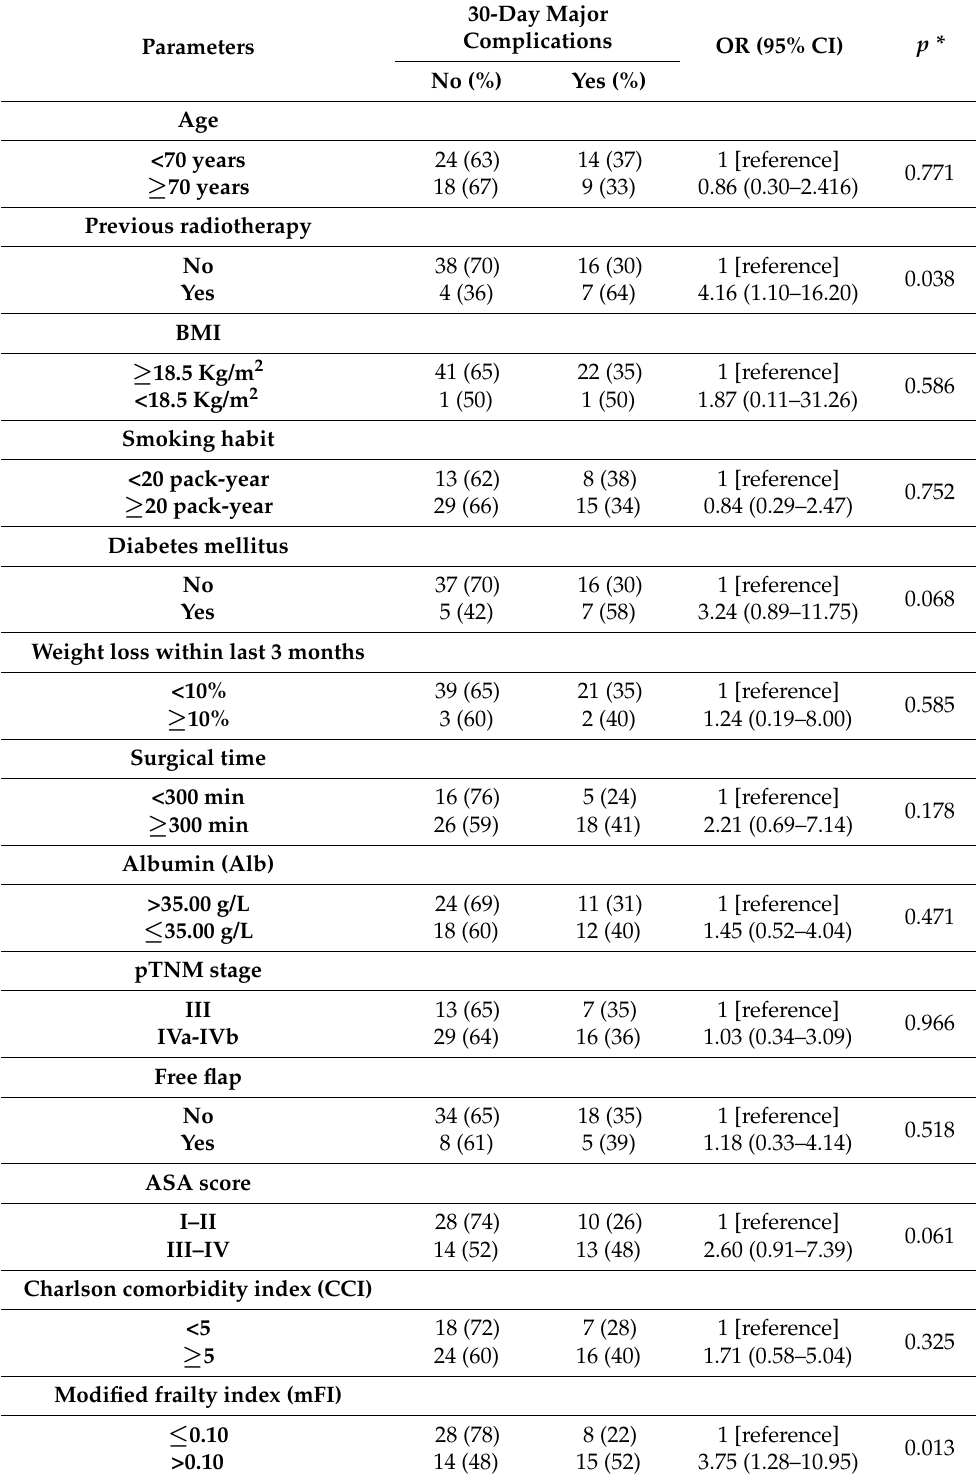
Table 2. Thirty-day major postoperative complications and dichotomized clinical predictors, univari- ate analysis; * Fisher’s exact test or Chi-squared test, as appropriate. BMI: body mass index; ASA: American Society of Anesthesiologists; CSA: cross-sectional area; SMM: skeletal muscle mass; CSMI: cervical skeletal muscle